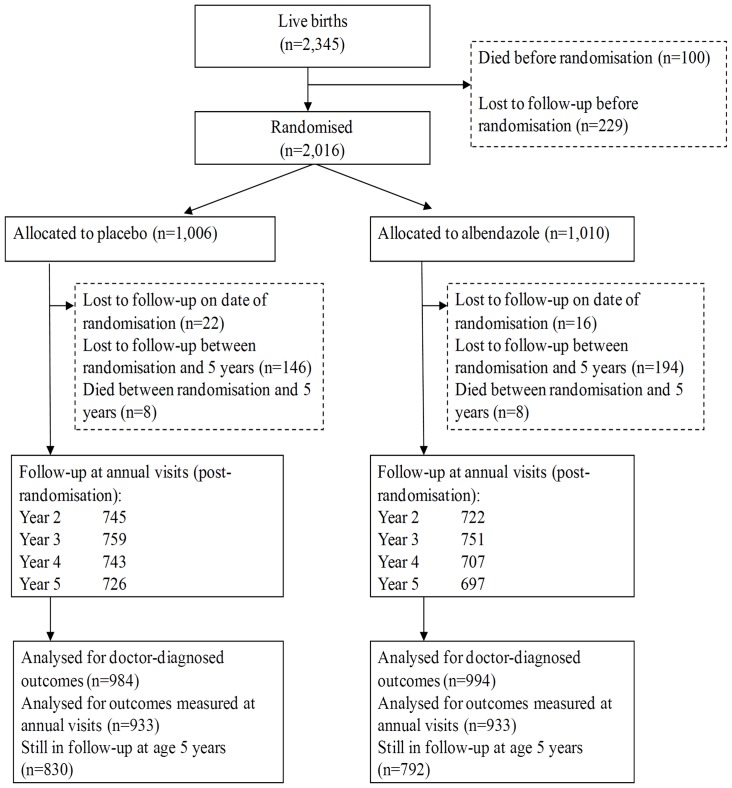
Flow of participants through the childhood trial.